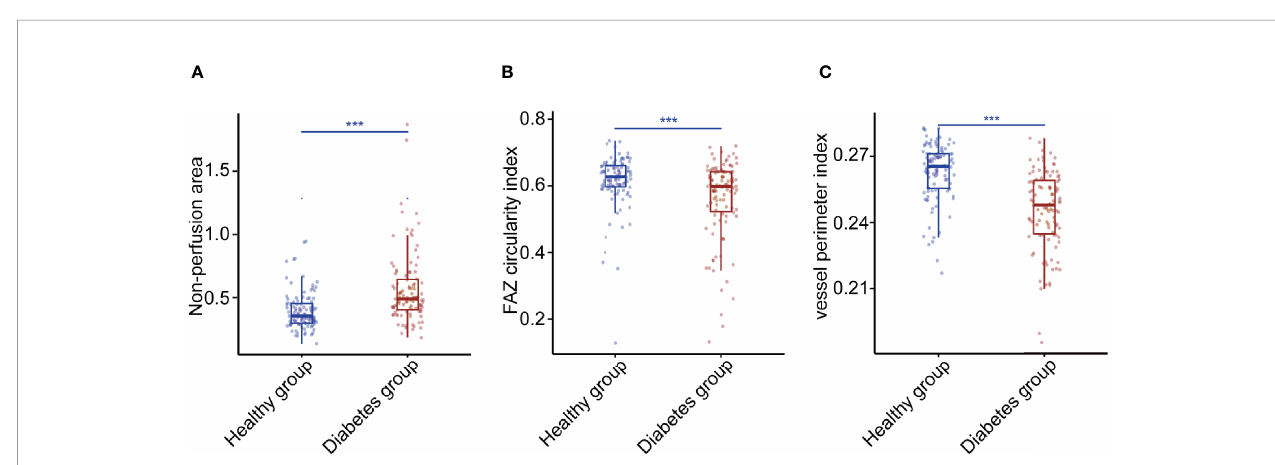
FIGURE 4 | The systemic risk factors associated with OCTA metrics. FDR-corrected P-values were calculated by Wilcox